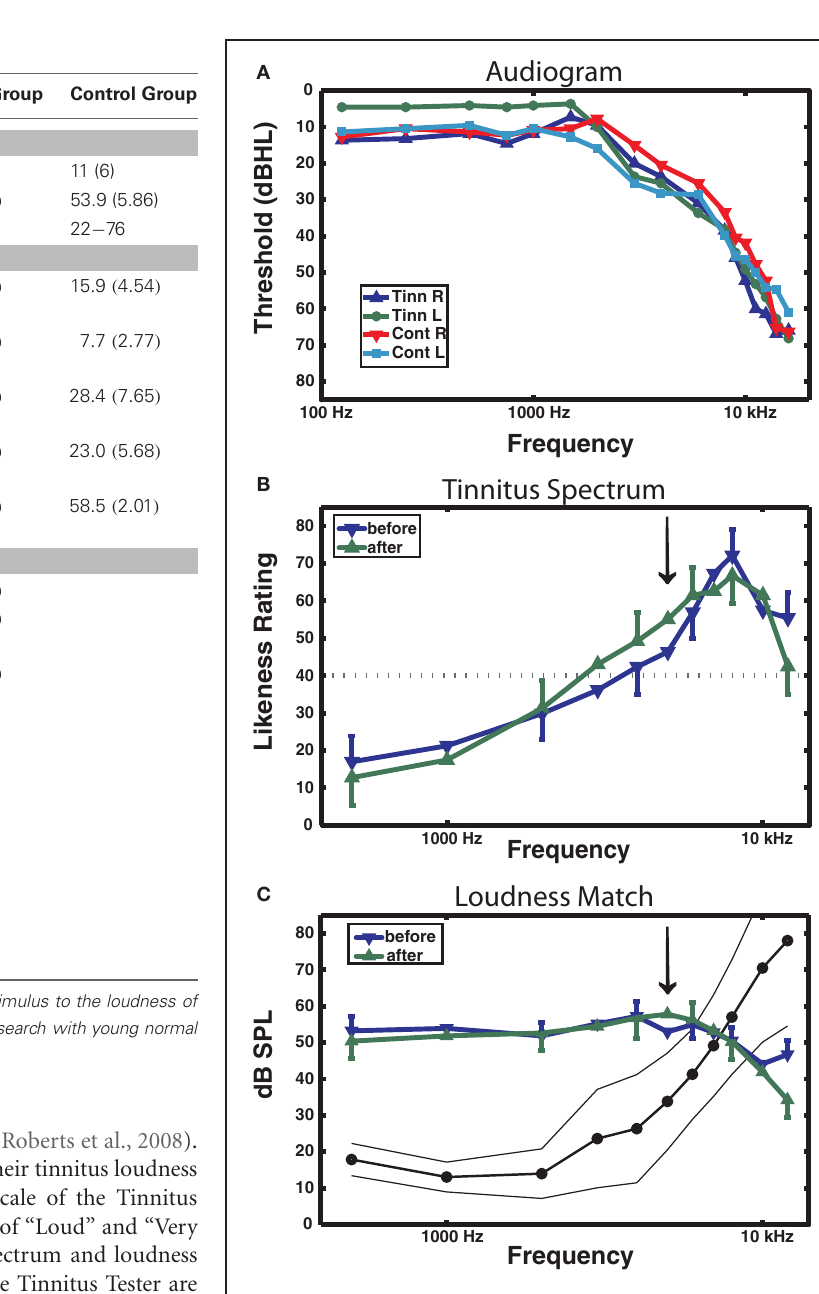
FIGURE 2 | Audiometric and psychoacoustic measures. (A) Audiogram for each group, right and left ears shown separately. For clarity, error bars are omitted (group main effect F < 1). (B) Tinnitus spectrum (likeness ratings) before and after training in the tinnitus group, from the Tinnitus Tester software (Roberts et al., 2008). A likeness rating of 40 (broken line) corresponds to sounds beginning to resemble the individual’s tinnitus (the lower boundary of the tinnitus spectrum; Roberts et al. (2008). The arrow denotes the 5kHz training frequency. (C) Loudness matches from the Tinnitus Tester, before and after training. The line connected by dots denotes the group averaged audiogram converted from dB HL to dB SPL (thin lines denote between-subject 95% confidence limits). The difference between the audiogram and the loudness matches gives an approximate estimate of the loudness of the tinnitus in dB SL (Roberts et al., 2008). Error bars shown in panels (B) and (C) are the mean within-subject standard error (1